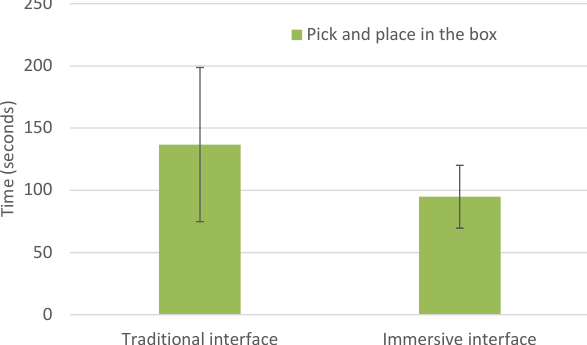
Figure 8. Task 2: mean task-time performance for picking and placing blocks in the box’s holes. Task 3’s mean time performance measurements are presented in Figure 9a and in Table